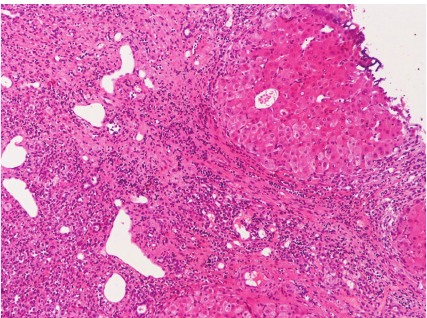
Figure 4: The neoplastic cells are negative for UCHL-1, a pan T-cell marker (anti-UCHL-1